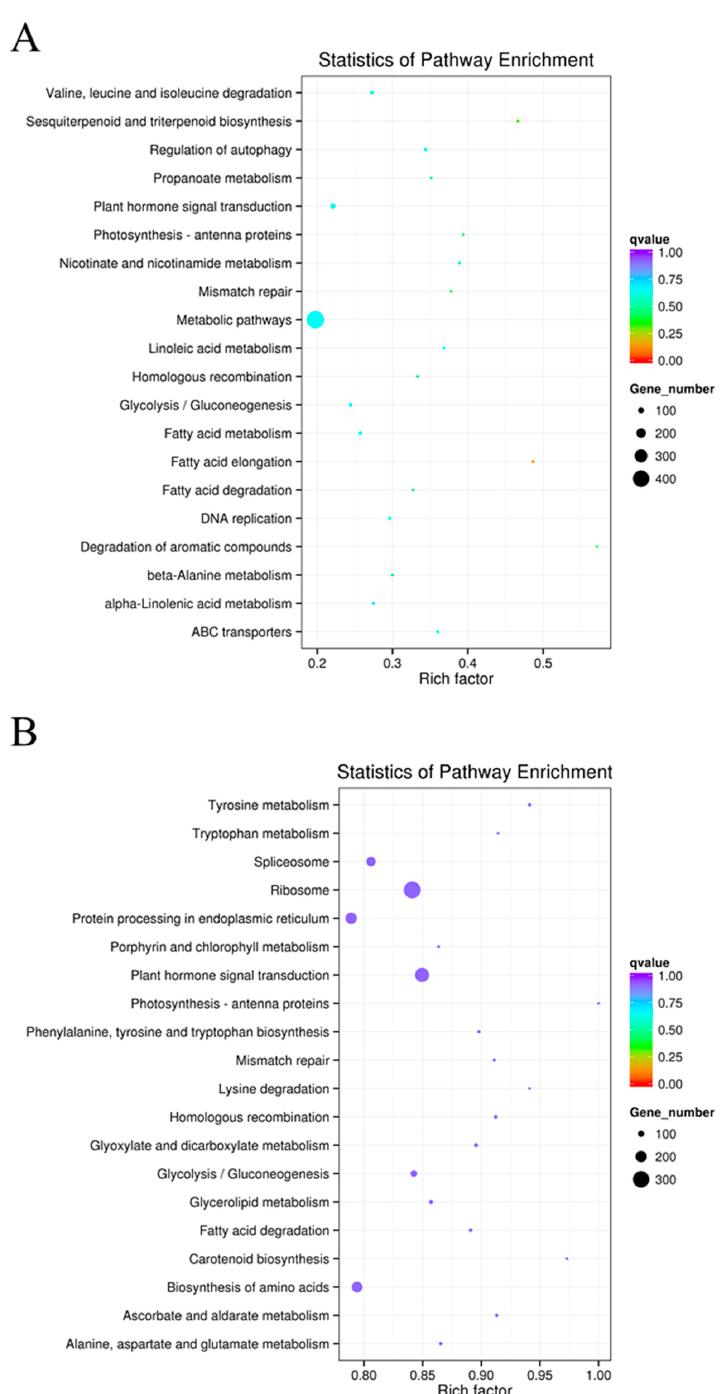
Figure 4. Statistics of Kyoto Encyclopedia of Genes and Genomes (KEGG) pathway enrichment analysis of the mRNAs co-located ( A ) and co-expressed ( B ) with differentially expressed lncRNAs between potato dormant tubers (DTs) and sprouting tubers (STs). The KEGG pathways are plotted along the ordinate, and the enrichment factor (rich factor) is plotted along the abscissa. The colours of points represent q values, and the sizes of points represent the number of mRNAs related to differentially expressed lncRNAs mapped to the reference pathway. Legends for the q value colour scale and the size scaling of the number of mRNAs related to differentially expressed lncRNAs are shown on the right side of the plot.